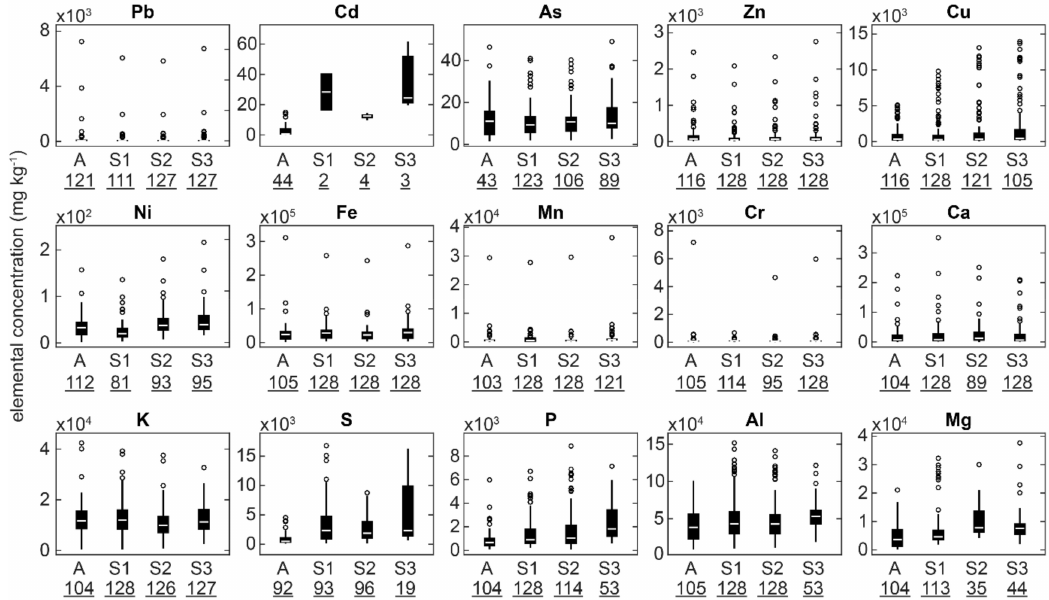
Figure 4. Boxplots of soil elemental concentrations. Boxplots showing the distribution of elemental soil concentrations in all samples as measured by laboratory analysis (A), scanner 1 (S1), scanner 2 (S2) and scanner 3 (S3). The white line corresponds to the median value, the whiskers correspond to the most extreme data points which are not outliers and the dots correspond to extreme values considered as outliers ( > 1.5 × interquartile range). The number of soil samples comprised within each boxplot is written underneath each boxplot